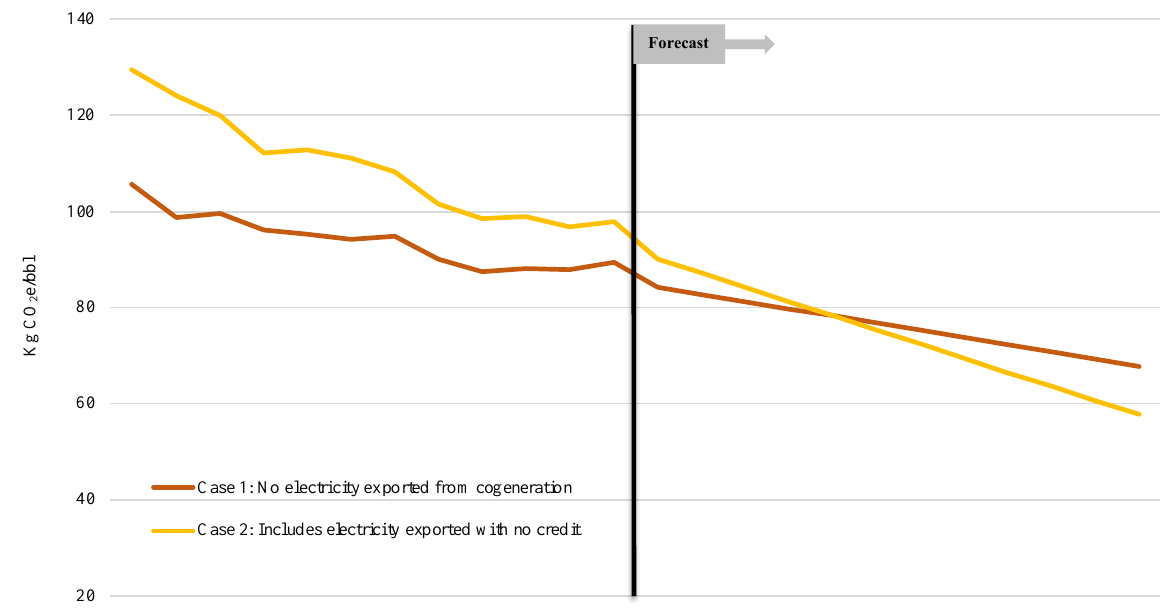
Figure 6. GHG emissions intensity of SAGD operations: historical and outlook (2007–2030) with an example of linear modeling of past performance for Cases 1 and 2.